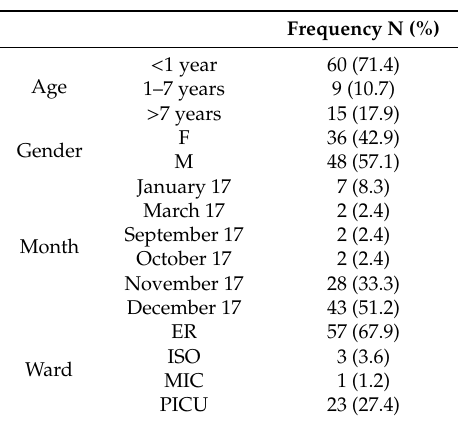
Table 1. Demography of respiratory syncytial virus (RSV) positive